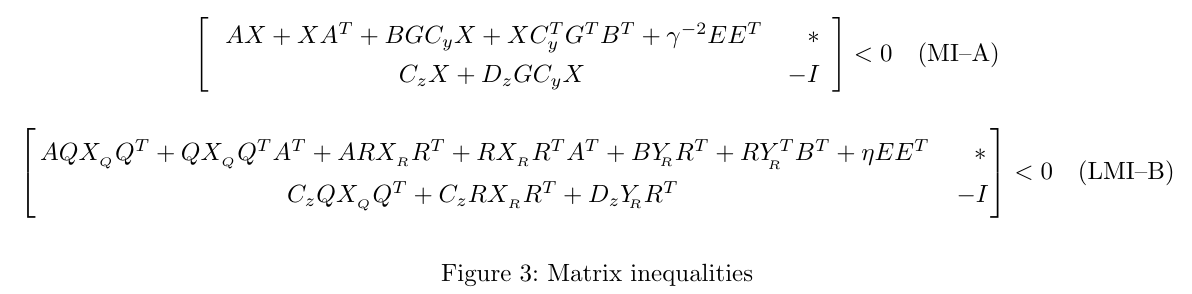
Figure 3: Matrix